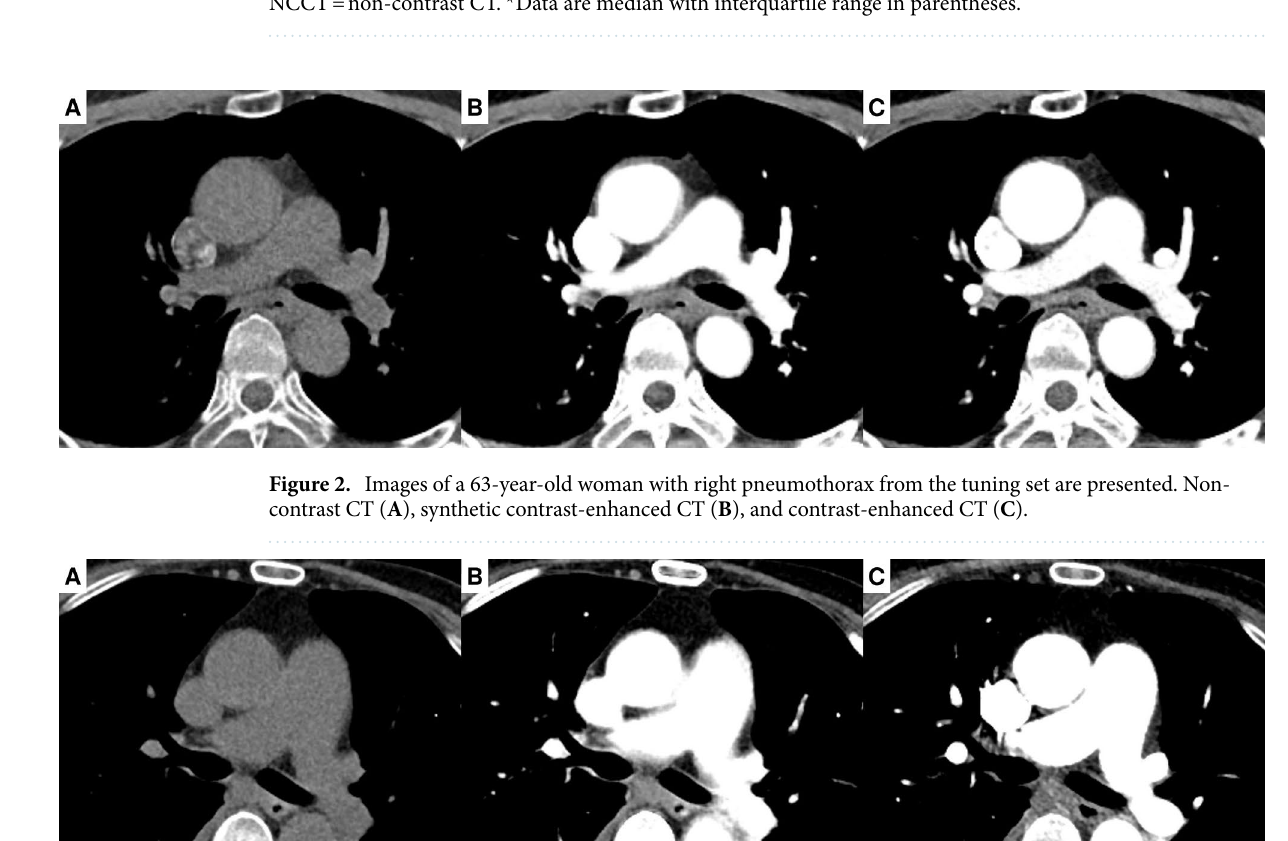
Table 1. Patient characteristics and CT acquisition parameters. Note Siemens is located in Erlangen, Germany. Philips is located in Andover, Massachusetts. CECT = contrast-enhanced CT, VNC = virtual non-contrast CT, NCCT = non-contrast CT. *Data are median with interquartile range in parentheses.